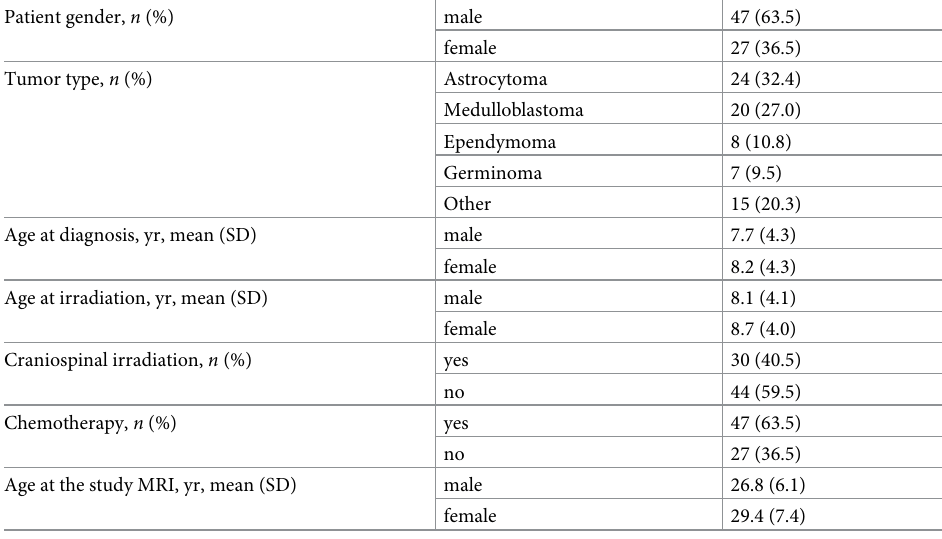
Table 1. Patient characteristics and tumor types.